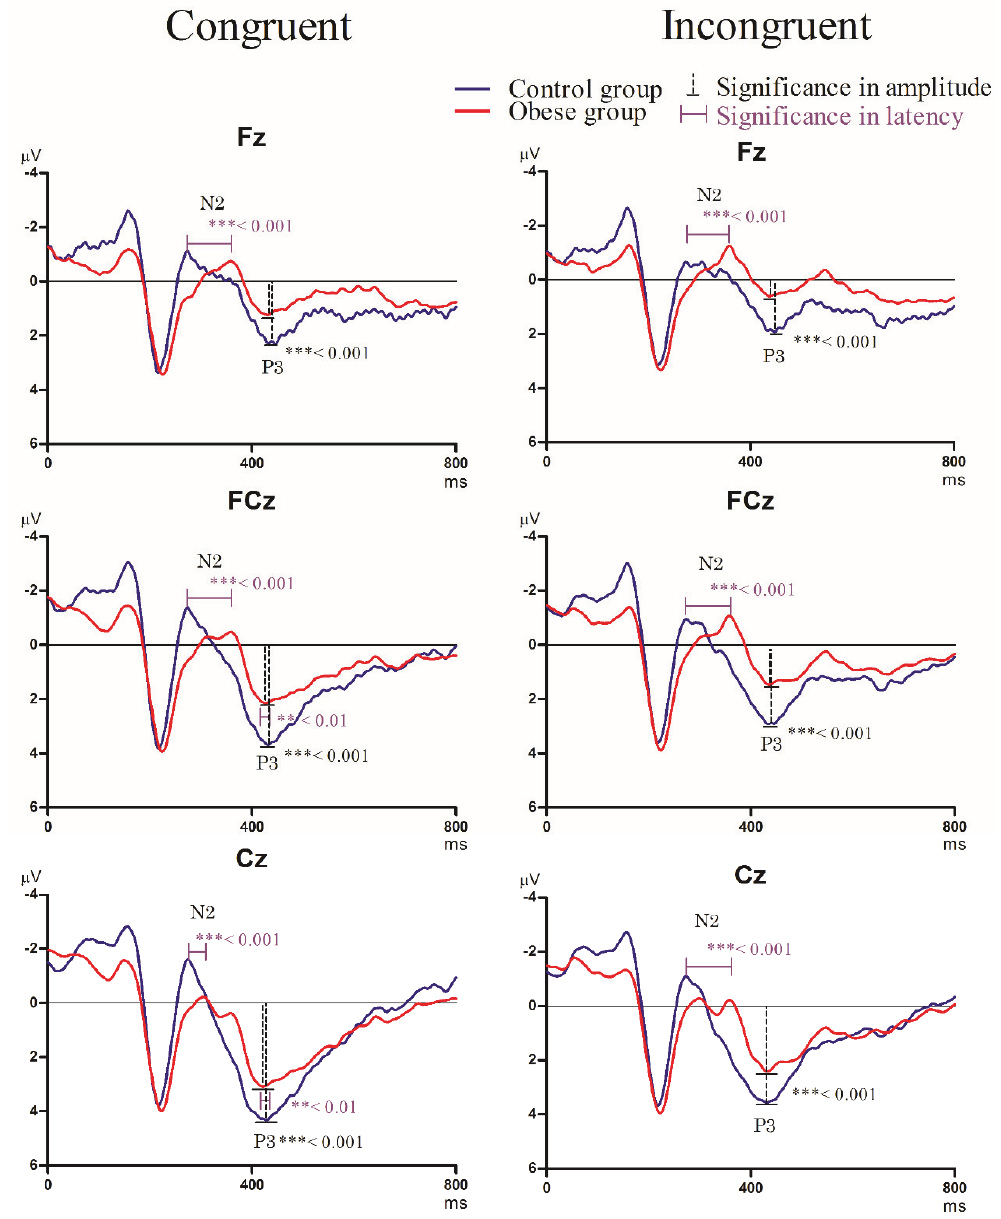
Figure 2. Grand averaged ERPs of N2 and P3 waveforms in the congruent and incongruent conditions in three electrodes (Fz, FCz, and Cz) for the normal-weight control group (CG) and the obese group (OG) in the Stroop task.